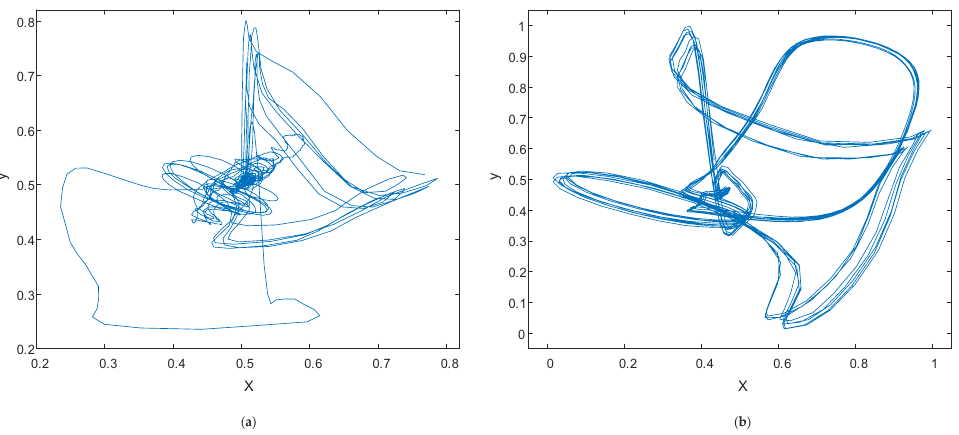
Figure 3. Phase space trajectories of VF and nVF split frames. ( a ) VF split frame; ( b ) nVF split frame.